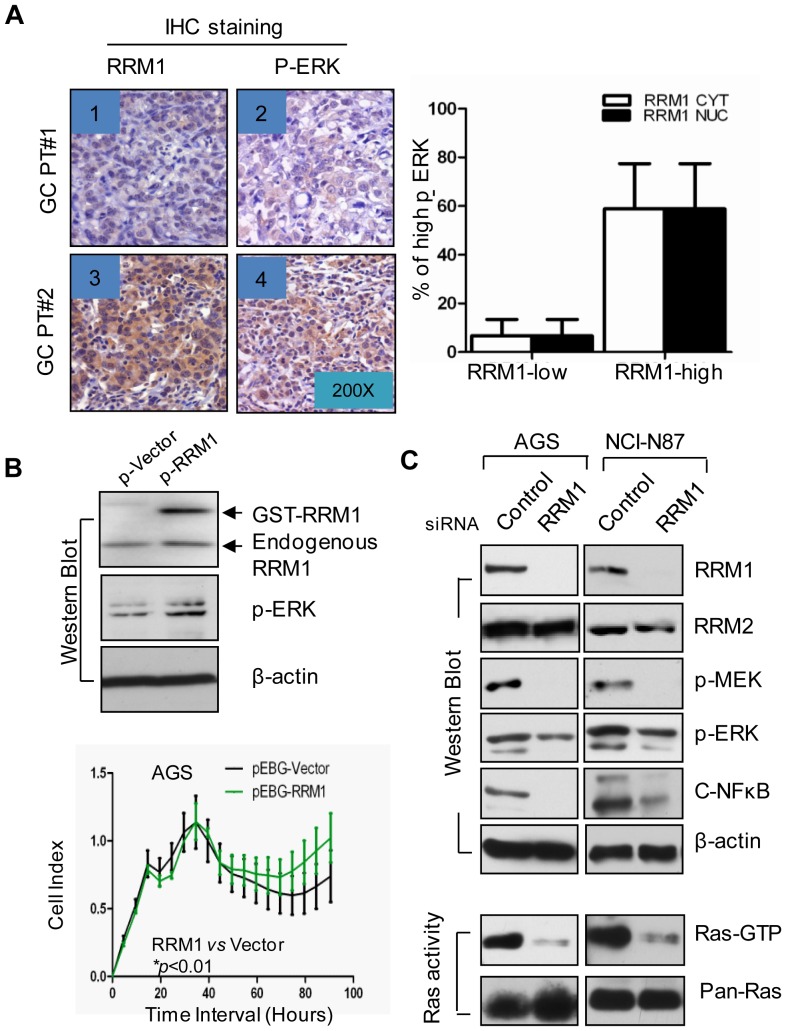
RRM1 promotes cell proliferation via Ras/Raf/MAPK pathway in GC.
A, RRM1 overexpression was found to be accompanied with high expression of p-ERK in GC patients (p<0.01, n = 32), windows 1–4 show representative pictures of p-ERK and corresponsive RRM1 staining in 2 cancerous tissues from two representative patients (Pic 1–2: GC No1; Pic 3–4: GC No2). B, Overexpression of RRM1 (both ectopic and endogenous RRM1) through transfection of pRRM1 (pEBG-RRM1) promotes AGS cell growth; p-ERK was also up-regulated subsequently. C, RRM1 was down-regulated with siRNA in two GC cell lines, AGS and NCI-N87. The cells were collected and analyzed with Western blot and Ras activity kit (Millipore, MA). The Ras-Raf activity was severely decreased and so were the downstream proteins p-MEK, p-ERK and c-NFκB.